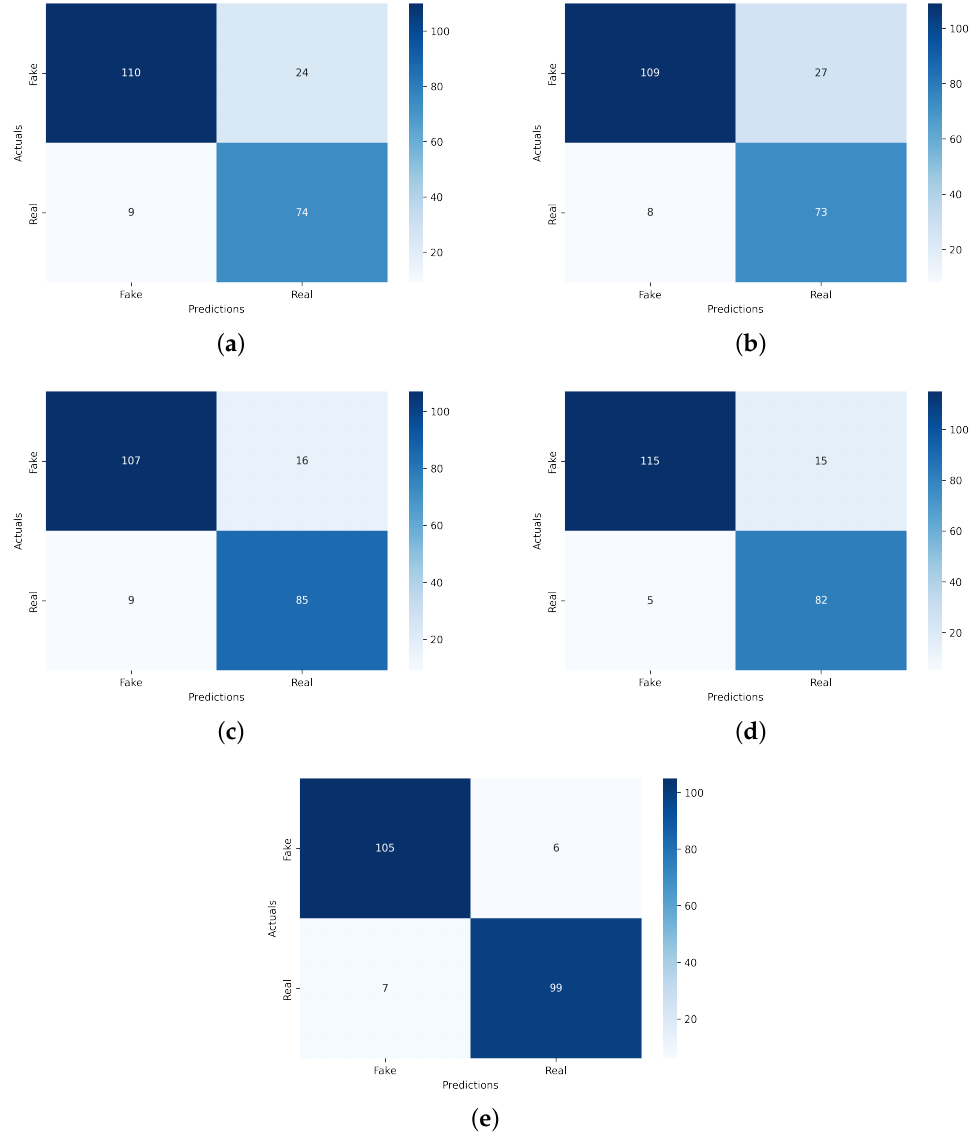
Figure 7. The confusion matrix analysis of employed neural network techniques is based on the validations of performance metrics results. ( a ) The confusion matrix of the Xception approach. ( b ) The confusion matrix of the NAS-Net approach. ( c ) The confusion matrix of the Mobile Net approach. ( d ) The confusion matrix of the VGG16 approach. ( e ) The confusion matrix of the proposed